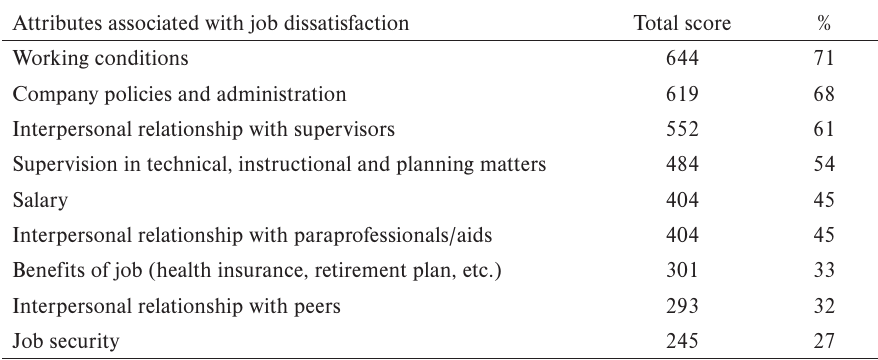
Ranking of APE specific factors attributed to job dissatisfaction for CAPES Attributes associated with job dissatisfaction Total score % Too much of paperwork (including IEP reports) Lack of priority for APE in scheduling within the schools Lack of teaching space Not involved or not included in IEP process Amount of time spent and distance going to schools 450 Large class size and high weekly student workload Lack of adequate equipment to meet the needs of students 417 APE students are very heterogeneous, variability is disconcerting APE students have severe disabilities Lack of school identity, interaction with other teachers Note. Range of possible answers scores is related to number of items in pairwise comparison and total number of respondents as each attribute is compared with all other attributes on the list. There- fore for the comparison of nine attributes maximum score (representing maximum dissatisfaction) is 9 × 110 =